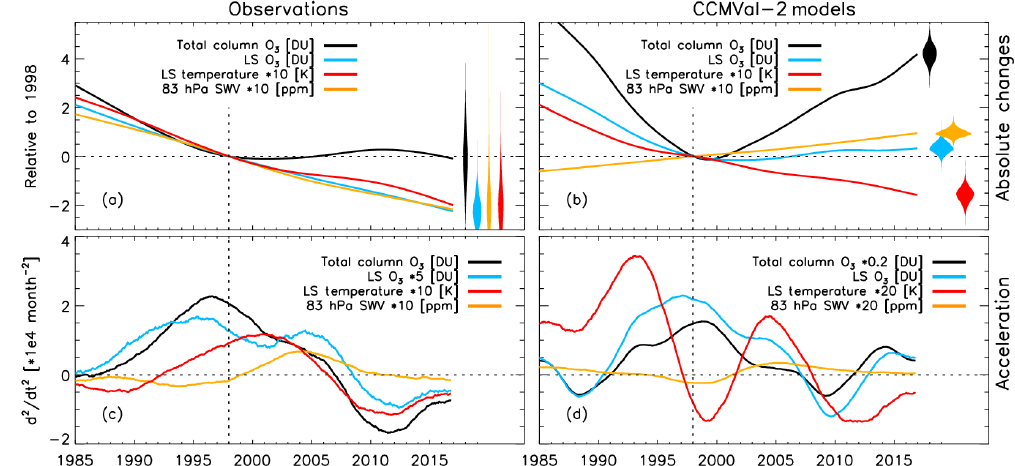
Figure 1. Global 60 ◦ S–60 ◦ N 1985–2016 stratospheric changes. (a) Observed non-linear trends for total column ozone (black), lower stratospheric ozone (blue), temperature (red), and stratospheric water vapour (SWV, yellow) relative to 1998, as well as their respective (c) acceleration curves (5-year smoothing). Panels (b, d) are as for (a, c) but for the multi-model mean (MMM). Units and scaling of each variable are indicated in the